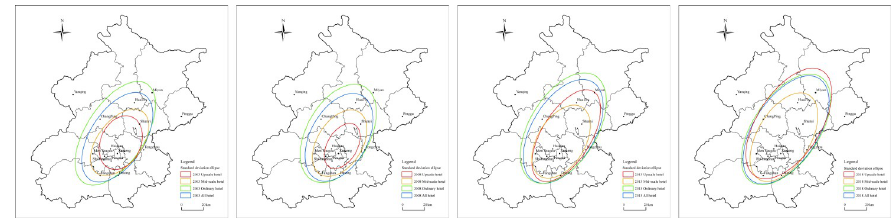
Fig 3. The standard deviation ellipse map of different types of hotels in Beijing 2003–2018. Different colors represent the spatial distribution of different types of hotel industry in Beijing. Among them, red represents the distribution of upscale hotels, orange represents the distribution of midscale hotels, green represents the distribution of ordinary hotels, and blue represents the distribution of all hotels. The figure is drawn by Arc GIS.